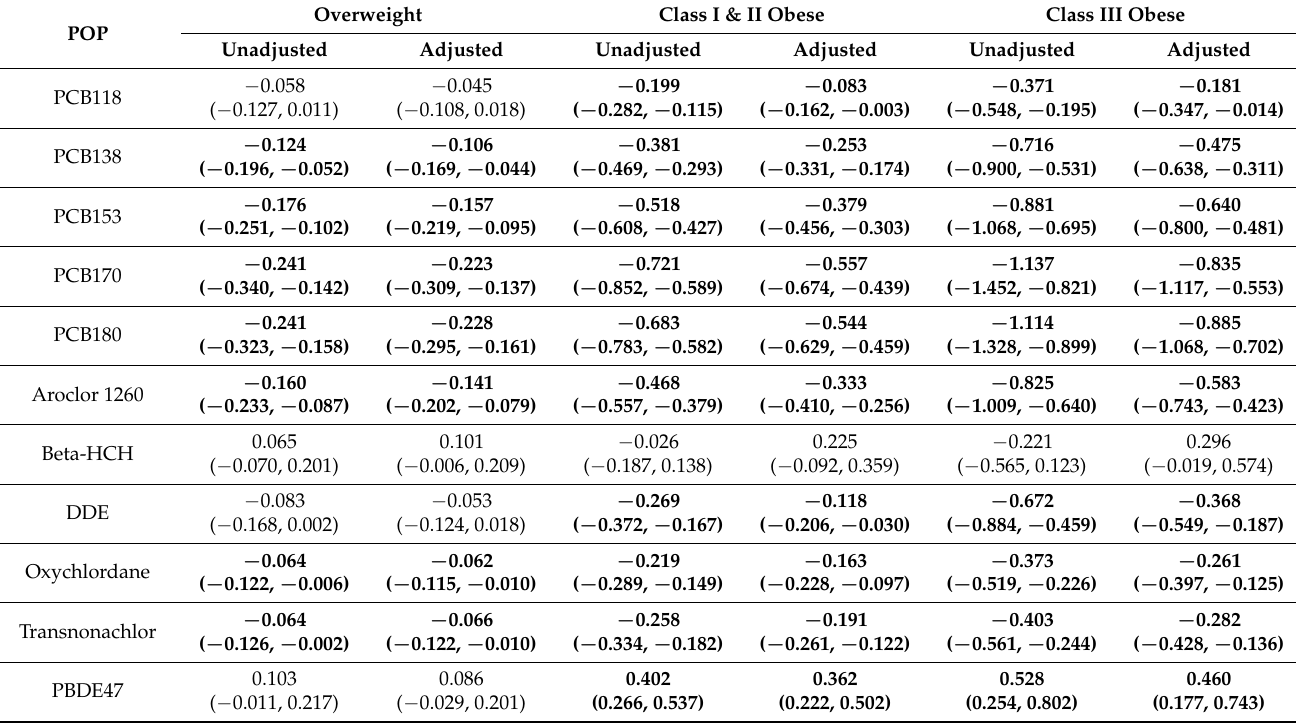
Table 3. Unadjusted and adjusted a associations [ β (95%CI)] between first-trimester body mass index (BMI) category and lipid-adjusted persistent organic pollutant (POP) concentrations detected in at least 50% of the sample, MIREC Study b